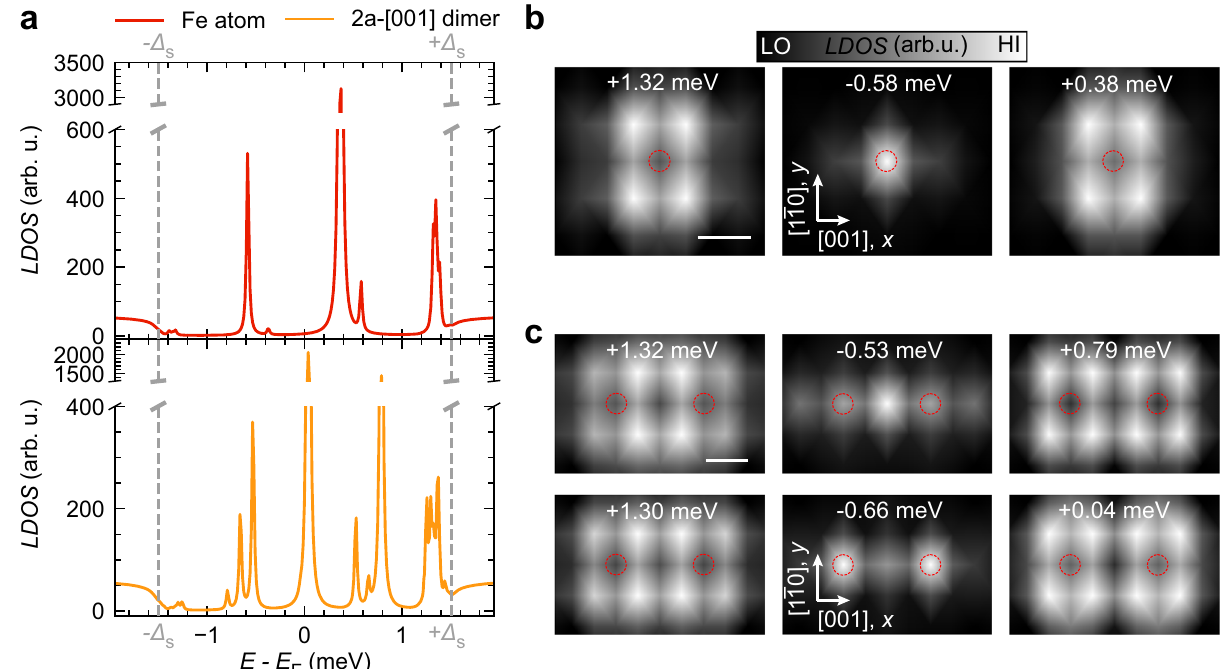
Figure 2 Calculated Yu – Shiba – Rusinov (YSR) states of Fe atoms and dimers on monolayer Au on Nb(110). a Electron component of the local density of states (LDOS) in arbitrary units (arb. u.) of the single Fe atom (red curve) and the ferromagnetic 2 a − [001] dimer (orange curve). Gray dashed vertical lines indicate the superconducting gap of the substrate Δ s . b Spatial distributions of the three YSR peaks of the Fe atom with the highest intensities visible in the red curve of ( a ). c Spatial distributions of the six YSR peaks of the ferromagnetic (FM) 2 a − [001] dimer with the highest intensities visible in the orange curve of ( a ). The energies are indicated in the top of the panels of ( b ) and ( c ). Red dashed circles indicate the positions of Fe atoms and the white scale bars correspond to a distance of a